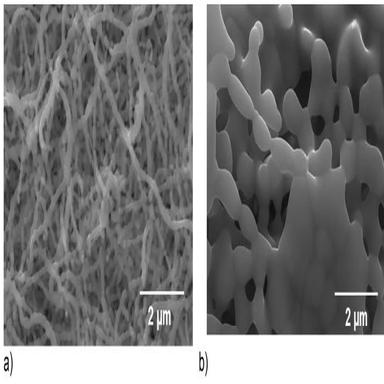
SEM micrographs (SE-mode) of the 10Mg–Zr fibers sintered with a heating rate of 10 K/min a) 1100 °C and b) 1350 °C.